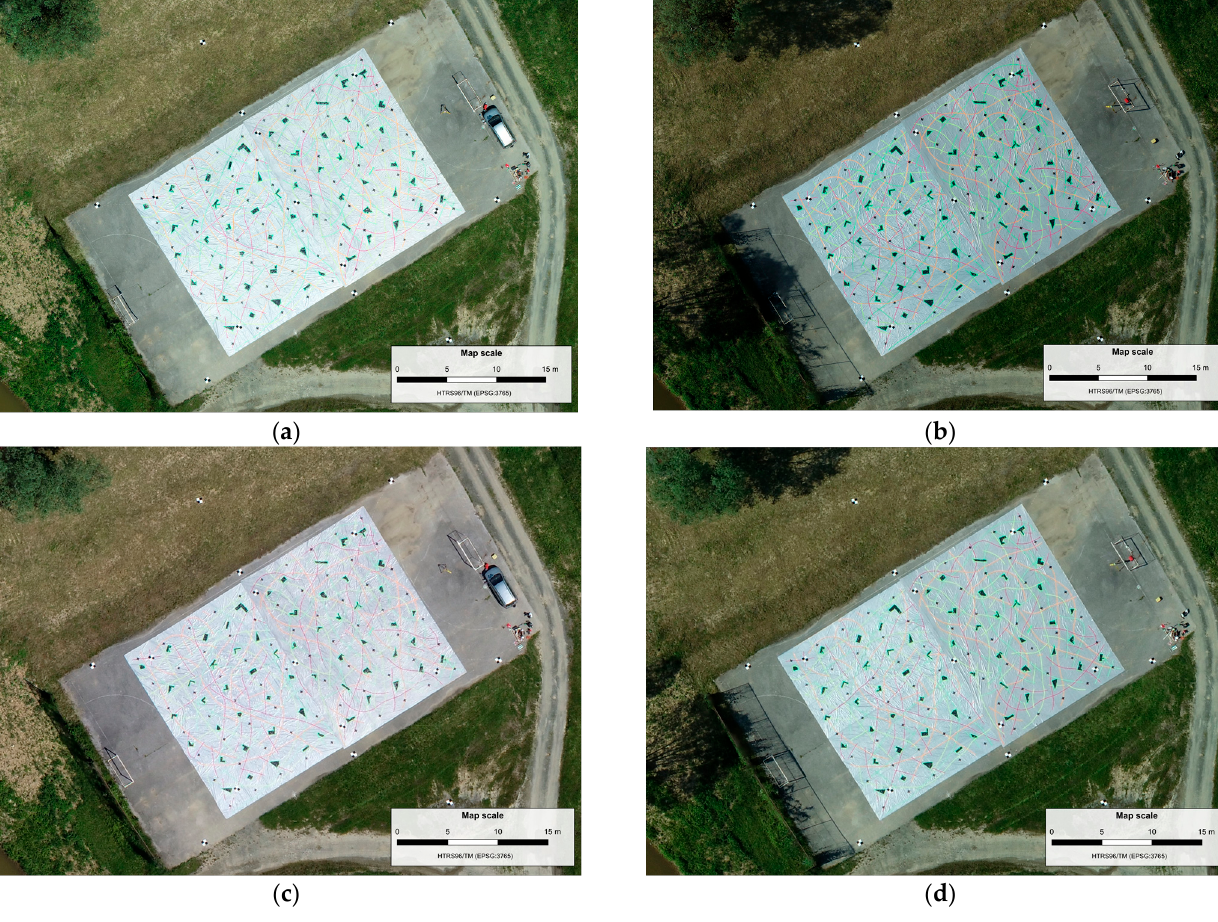
Figure 12. Orthomosaics of the test field in the first ( a ) and second ( b ) epoch of the first mission, and in the first ( c ) and second ( d ) epoch of the second mission.